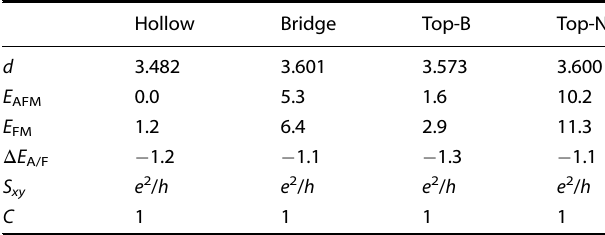
Table 1. Structural, magnetic, transport, and topological characteristics of the MBT 2SL